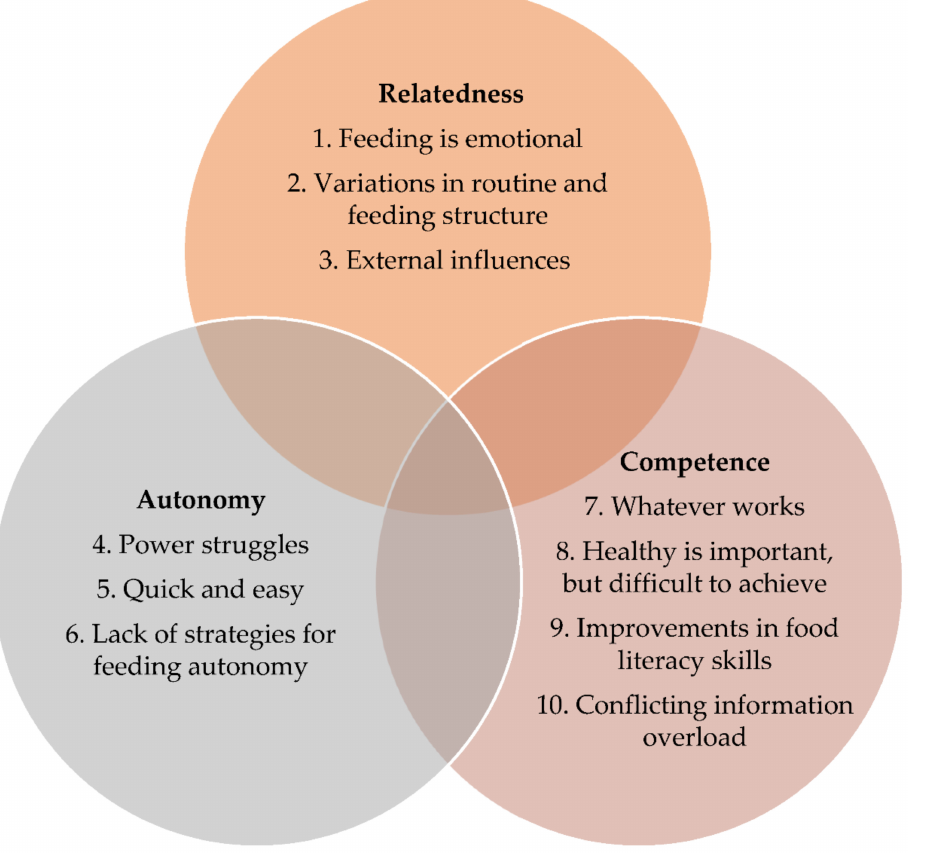
Figure 1. Categorization of themes aligned to self-determination theory (SDT)